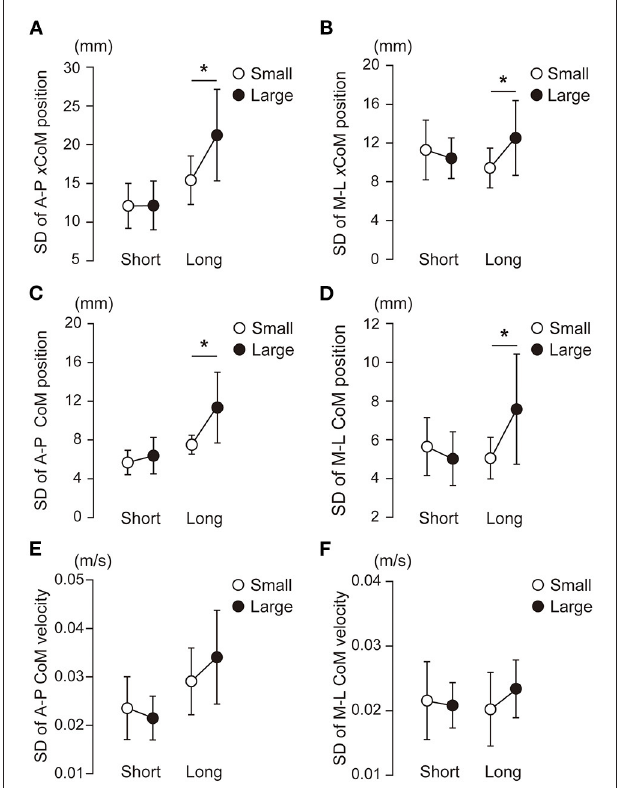
FIGURE 7 | Within-participant variability in the center of mass (CoM) state at the instance of takeoff of the leading leg. The white and black circles show the within-participant standard deviations. The error bars show the between-participant standard deviations of the within-participant variability. The extrapolated center of mass (xCoM, A,B ), CoM position (C,D) and CoM velocity (E,F) were analyzed. The left panels (A,C,E) show the CoM state in the anterior-posterior (A-P) axis, and the right panels (B,D,F) show the CoM state in the medial-lateral (M-L) axis. *Significant difference between the small and large target conditions ( p <